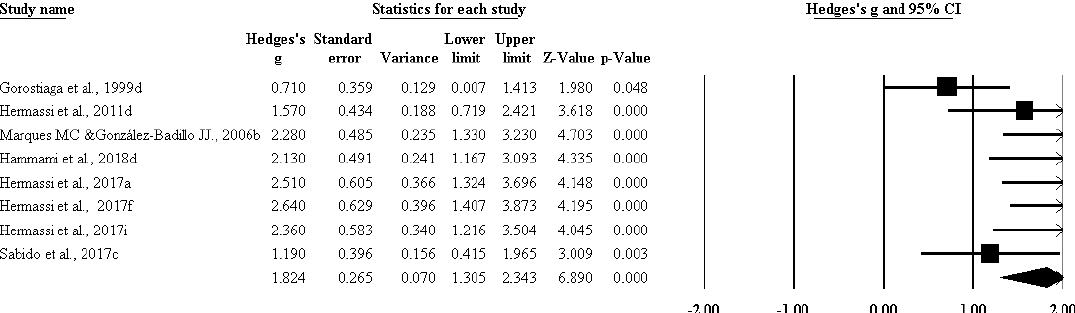
Figure 4. The impact of resistance training on isometric strength among handball players.